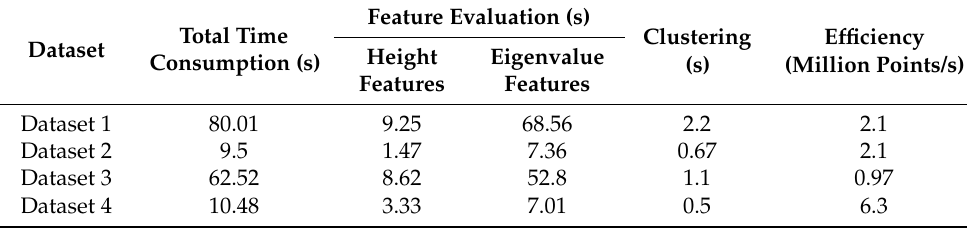
Table 7. Processing time for each step with the optimized